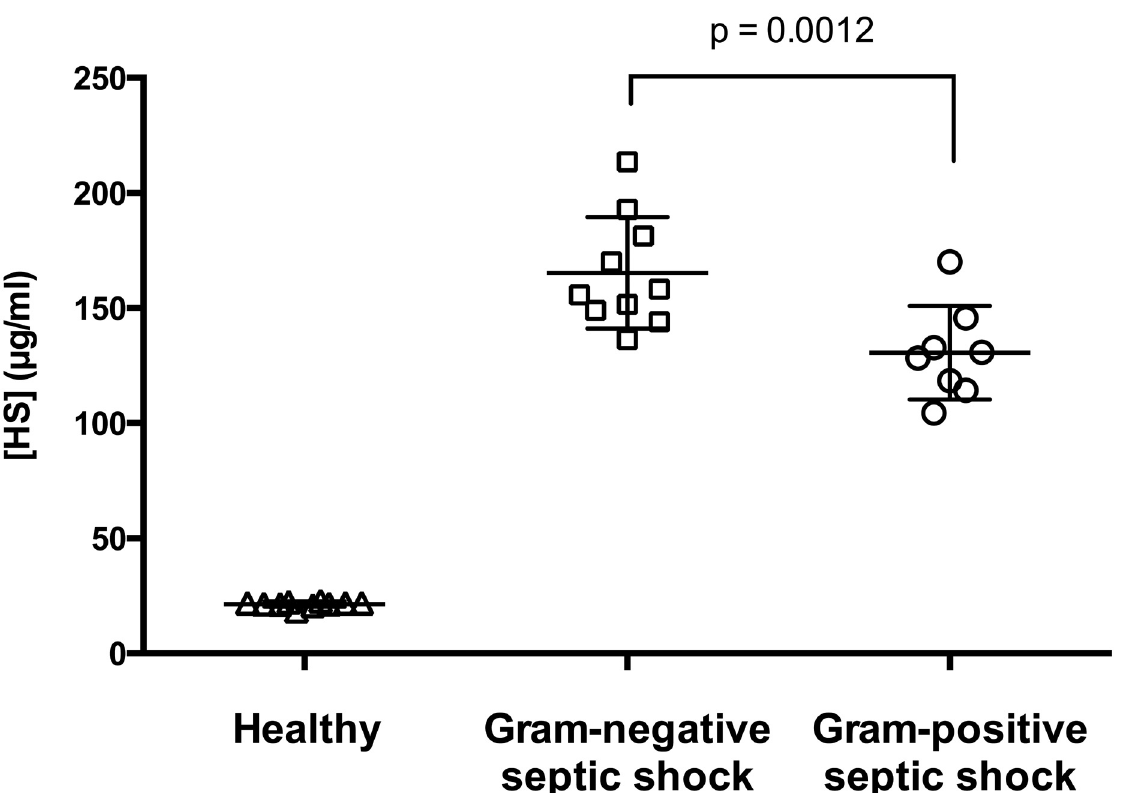
Fig 6. Heparan sulfate levels in human and murine sepsis. Heparan sulfate levels were measured in plasma of healthy humans (n = 10) as well as of patients with Gram-negative (n = 10) or Gram-positive (n = 8) septic shock using ELISA. Data represent the mean ± SD of duplicate samples. P value represent the statistically significance between HS level in Gram-negative and Gram-positive septic shock using 1-way-ANOVA and Tukey´s-Test for multiple comparisons.